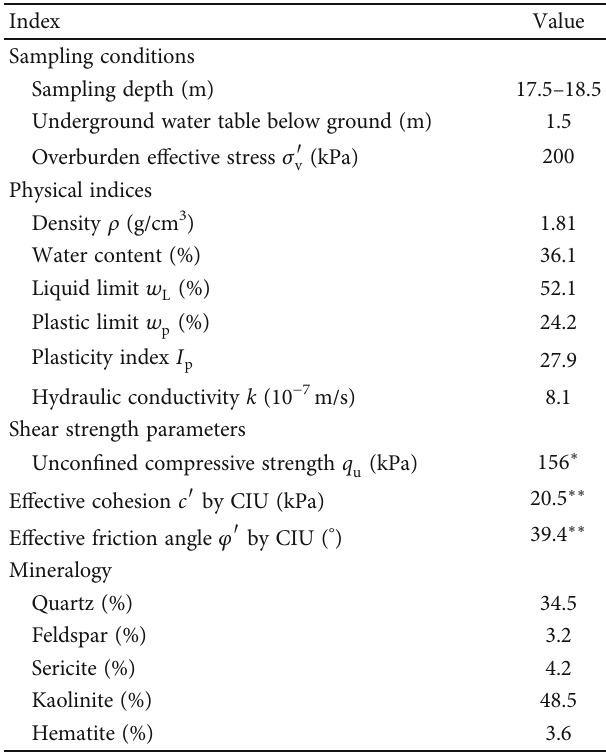
Table 1: Average index features of